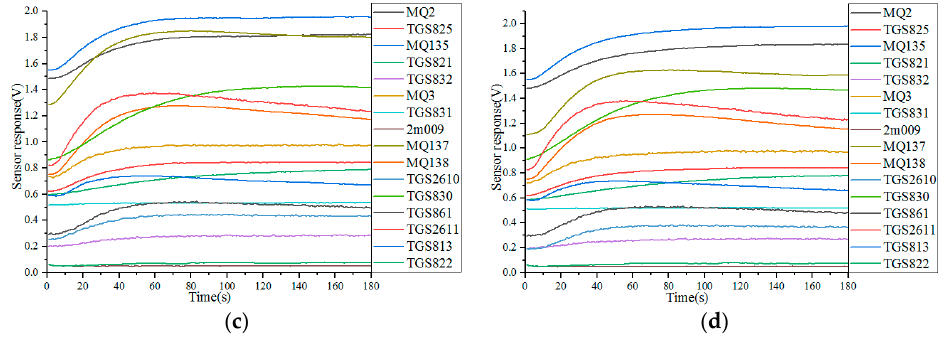
Figure 3. Sensor responses of four different paraffin samples: ( a ) Paraffin score 0.6; ( b ) Paraffin score 1.0; ( c ) Paraffin score 1.2; ( d ) Paraffin score 1.5.